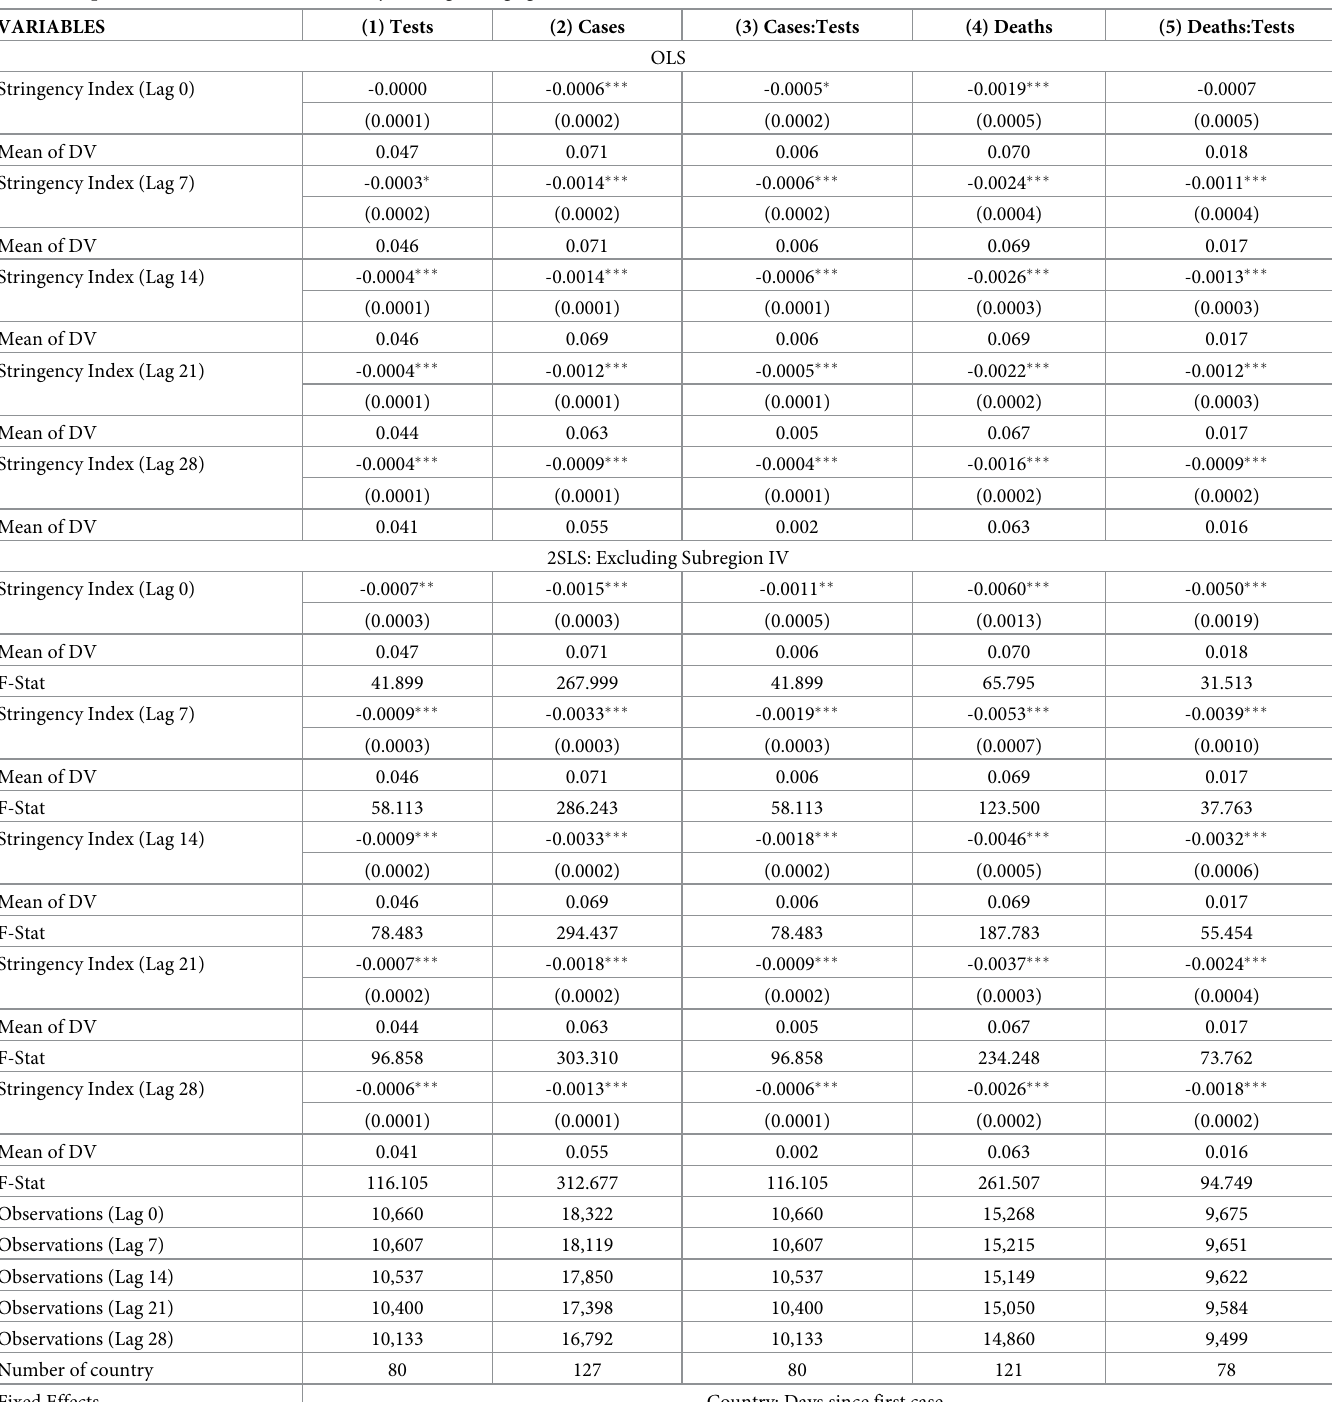
Table 3. Impact of stricter restrictions on 7-day moving average growth